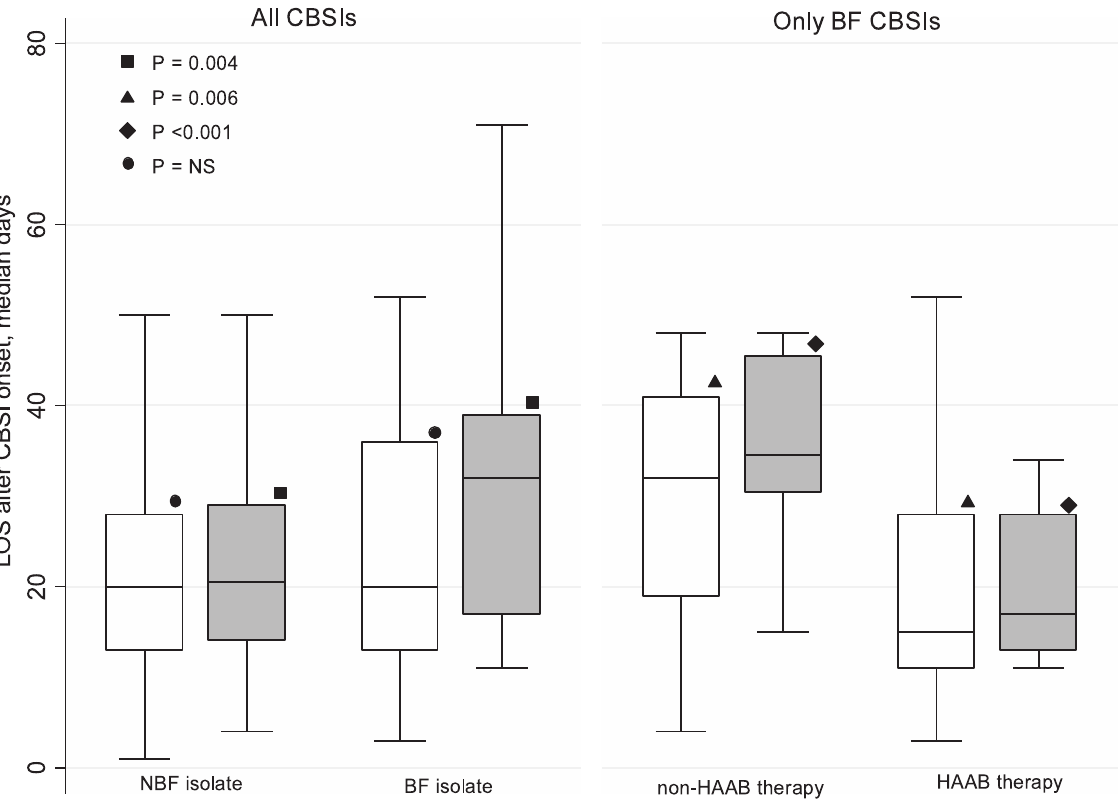
Figure 2. Hospital length of stay (LOS) following the Candida bloodstream infection (CBSI) onset in all (white box-plots) or surviving (grey box-plots) patients. Patients were grouped according to the biofilm-forming (BF) or non-biofilm-forming (NBF) Candida isolate (for all CBSIs), and according to receiving of highly active anti-biofilm (HAAB) or non-HAAB antifungal therapy (for BF CBSIs only). Lines inside the boxes indicate the median values, whereas upper and lower limits of the boxes and whiskers indicate the interquartile and total ranges, respectively. P-values for statistically significant differences between the groups are shown.